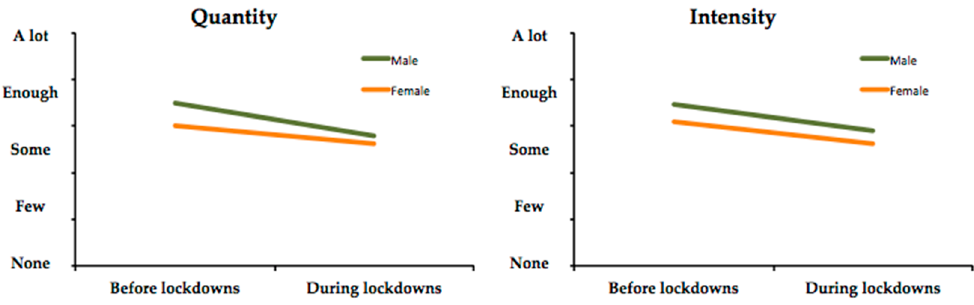
Figure 2. Comparative variation in quantity and intensity based on gender.